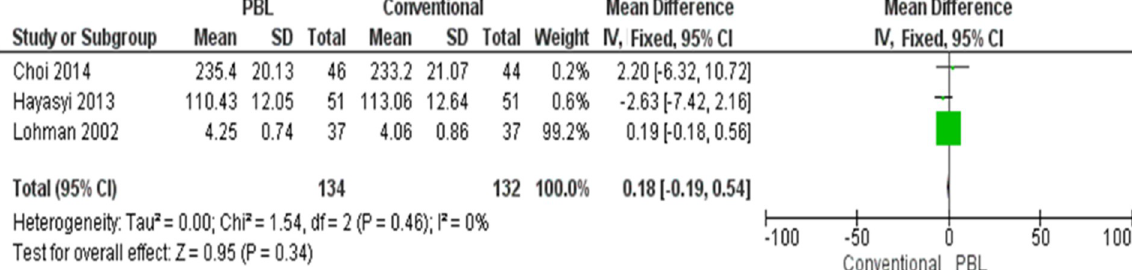
Fig 5. Self-directed learning evaluation in conventional teaching vs.